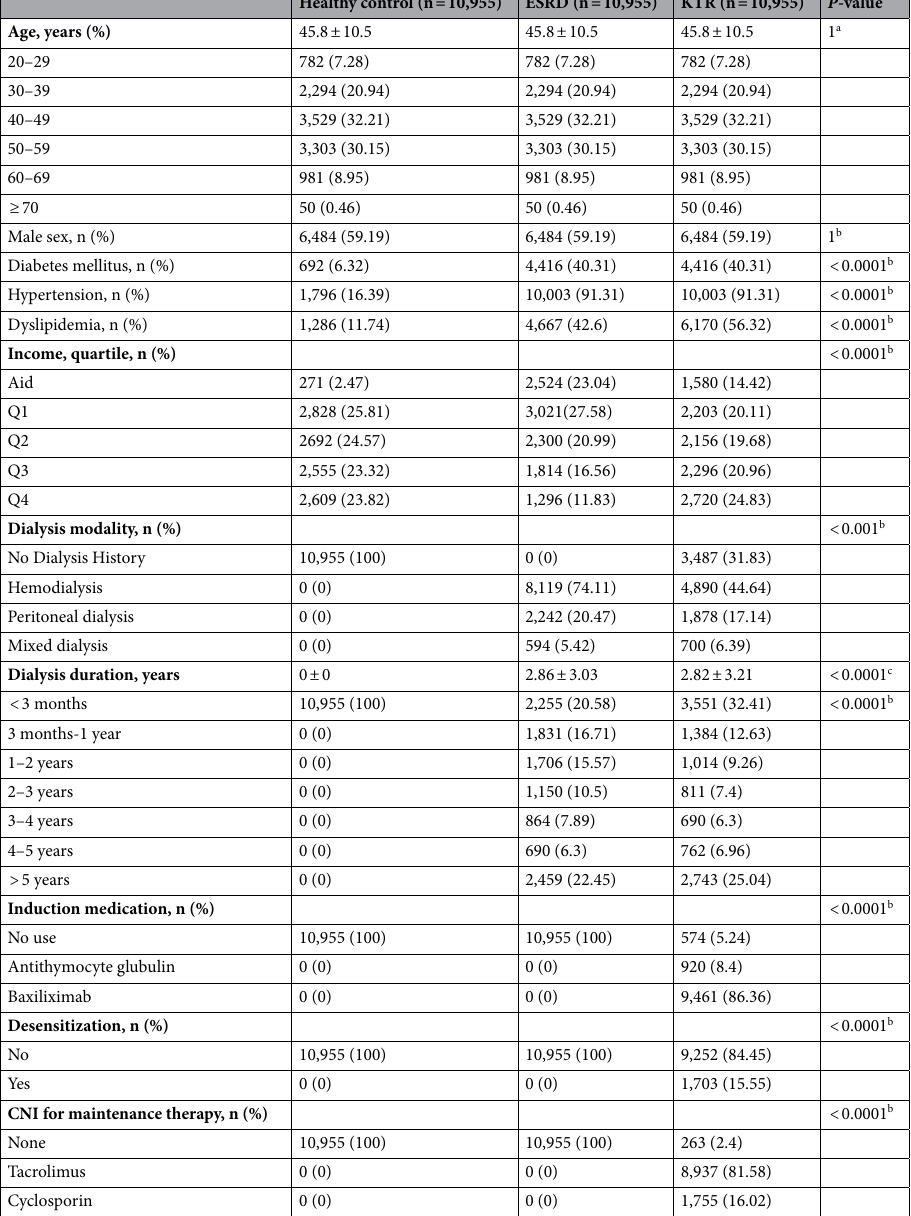
Table 1. Subject demographics. Mean ± standard deviation. ESRD end stage renal disease, KTR kidney transplantation recipients, CNI calcineurin inhibitor. a Comparison was performed using ANOVA. b Comparison was performed using chi-square test. c Comparison was performed using the Kruskal–Wallis test due to absence of